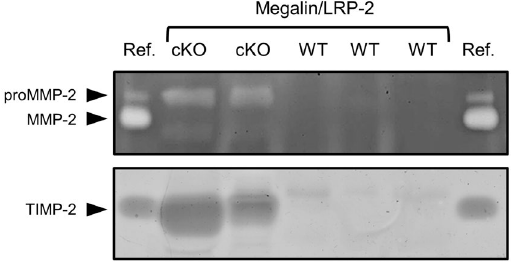
Figure 5. Invalidation of megalin/LRP-2 induces accumulation of proMMP-2 and TIMP-2 in urines. Twenty-four-hour urines were collected from 7-month-old Meg lox/lox ;Wnt4-Cre + mice (cKO) or their